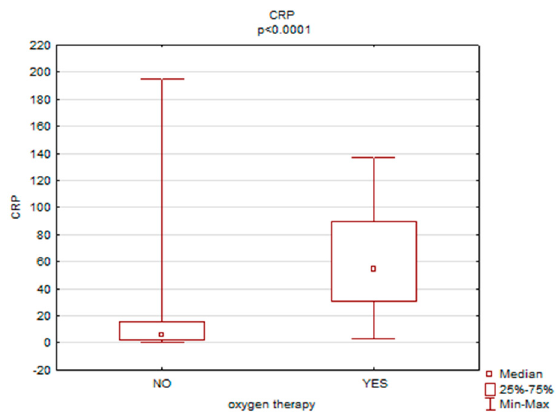
Figure 4. The necessity of oxygen therapy versus CRP levels.